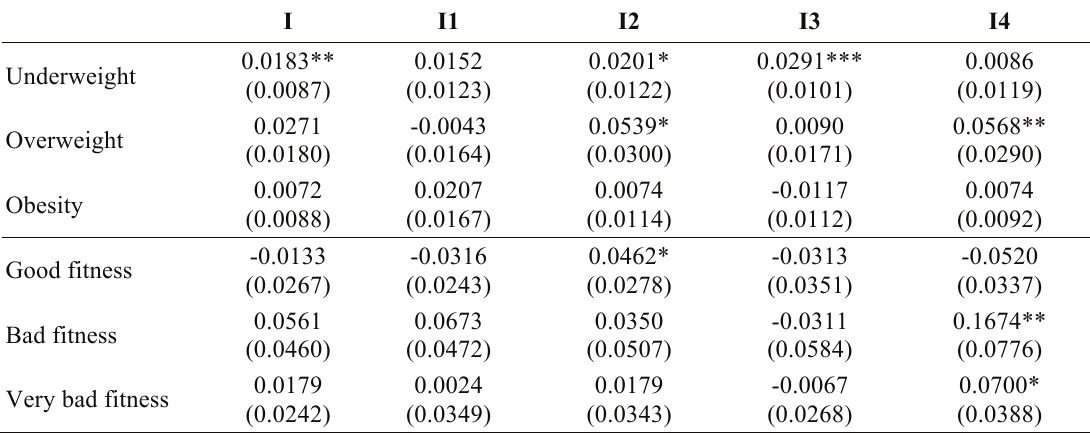
Table 5. Estimated health effect of the interventions on the tails I I1 I2 I3 I4